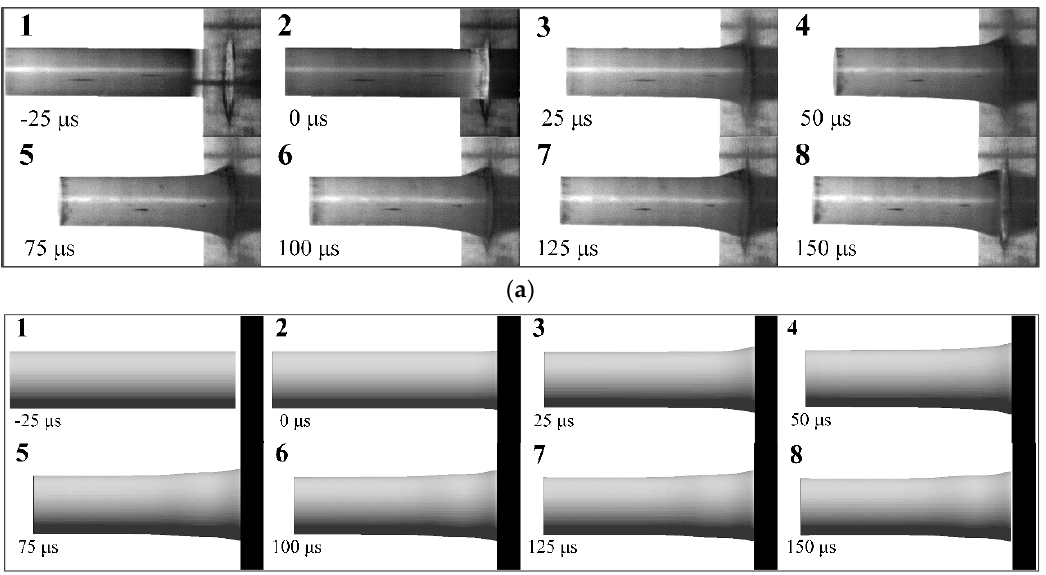
Figure 9. Taylor test at 128 m/s: ( a ) high-speed photographs; ( b ) deformation predictions using 3D simulation.